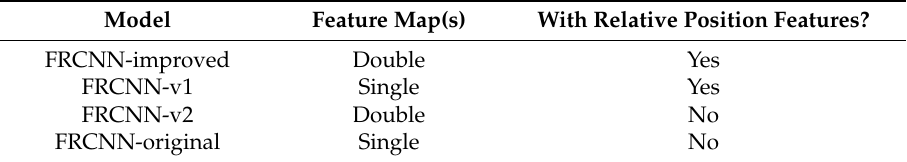
Table 4. The settings of the proposed model and the three models as